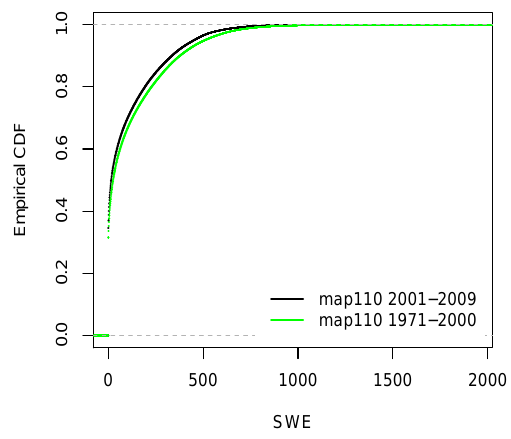
Fig. 2. Comparison of the SWE distribution in map110 during the training period (black) and the calibration period